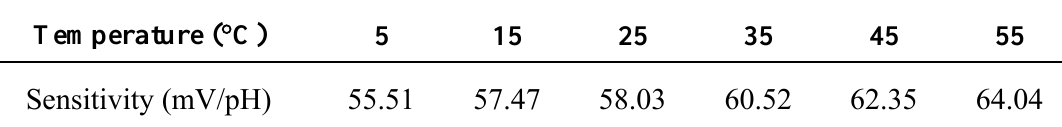
Table 2. Sensitivity of RuN thin film pH sensor at various temperatures.